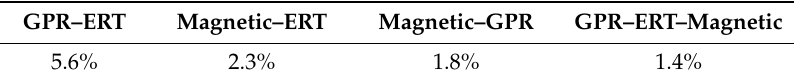
Table 4. Percentage of spatial